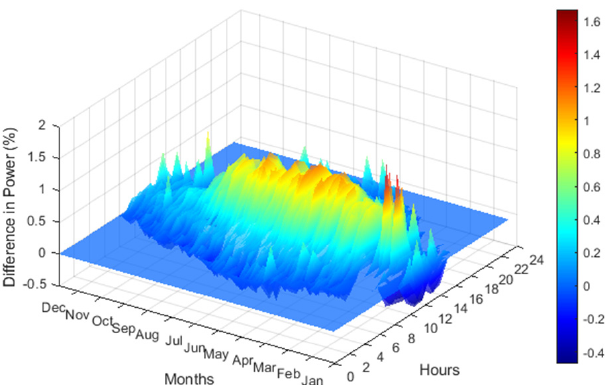
Figure 9. 3D power difference profile of the DSPI digital twin and the reference inverter.